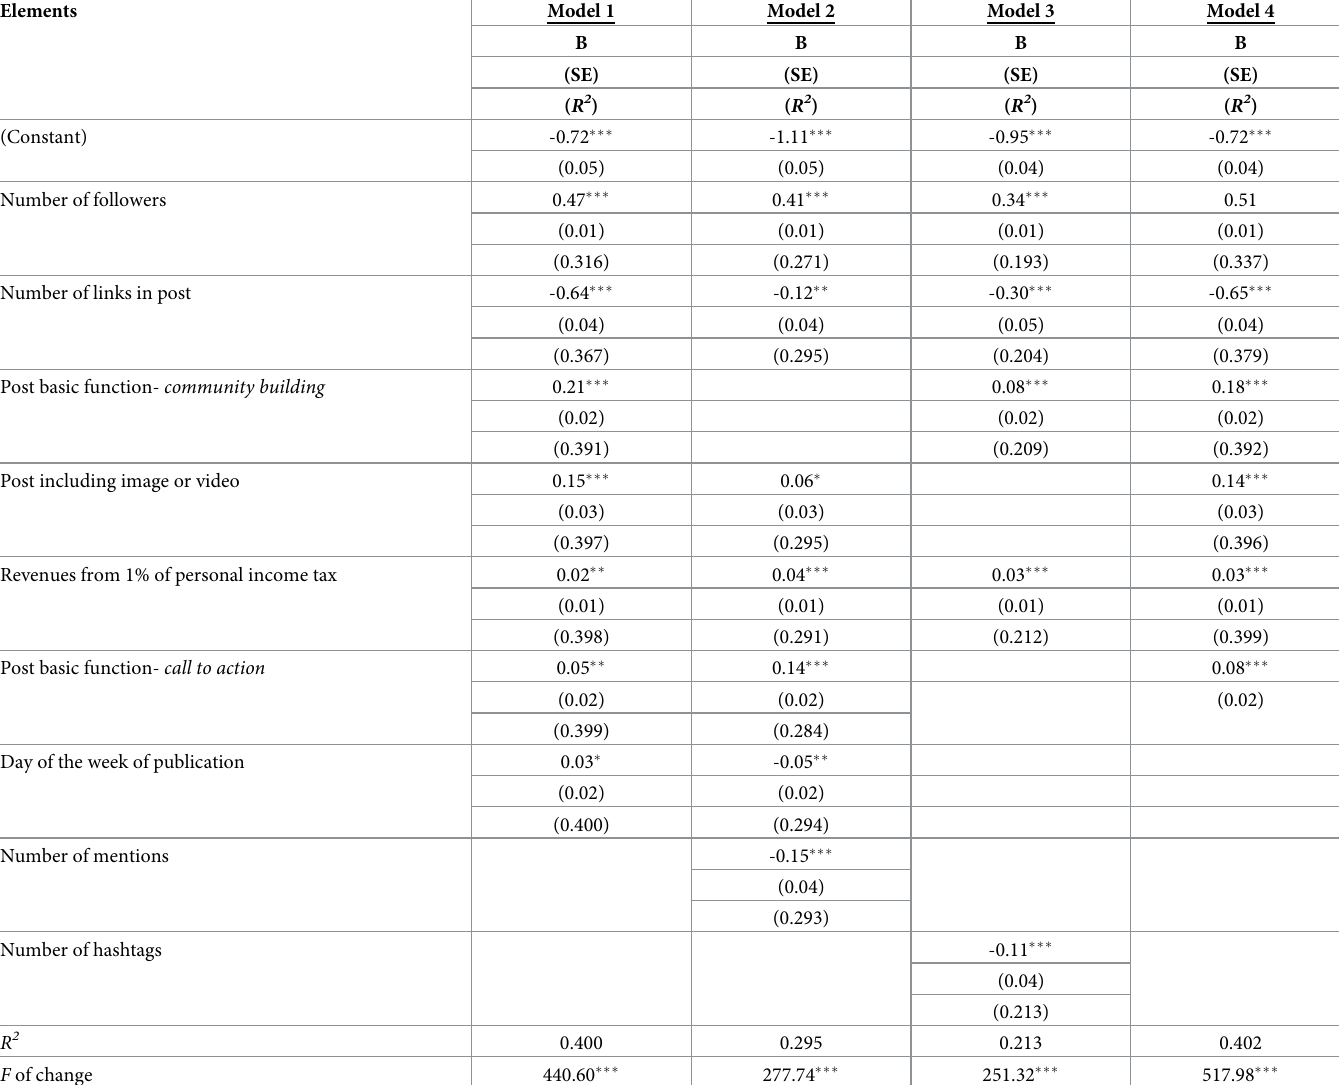
Table 2. A multiple regression analysis for factors affecting the average number of likes, shares, comments and total engagement.